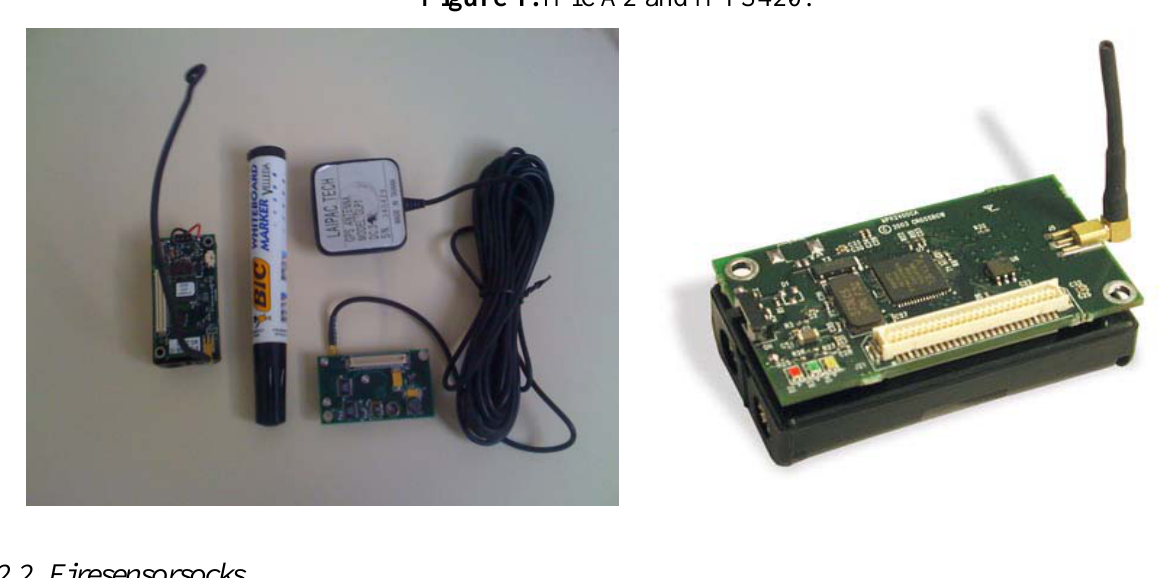
Figure 1. MICA2 and